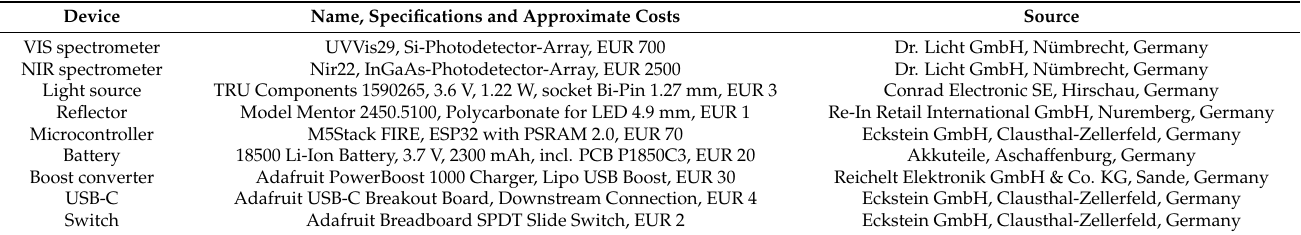
Table 1. Hardware components and their approximate prices of the OpenVNT